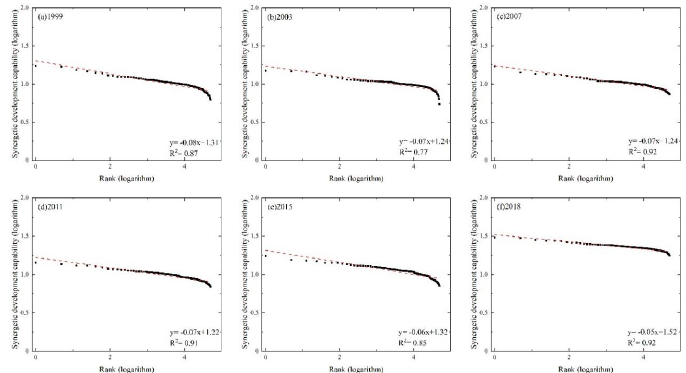
Figure 8. The rank-size rule of the coupling system in 110 cities.